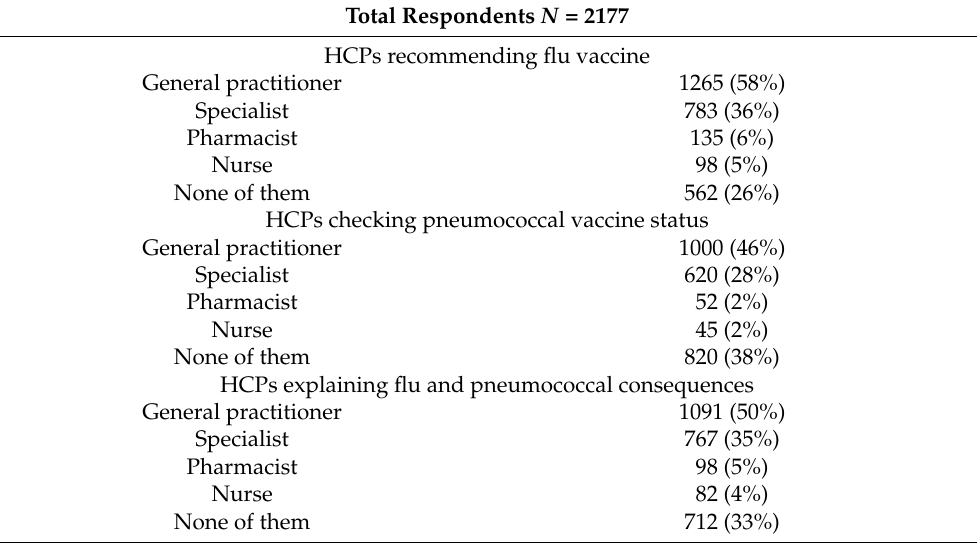
Table 4. Information about vaccine recommendations. Topics addressed by patients’ healthcare professionals (HCPs) over the last 12